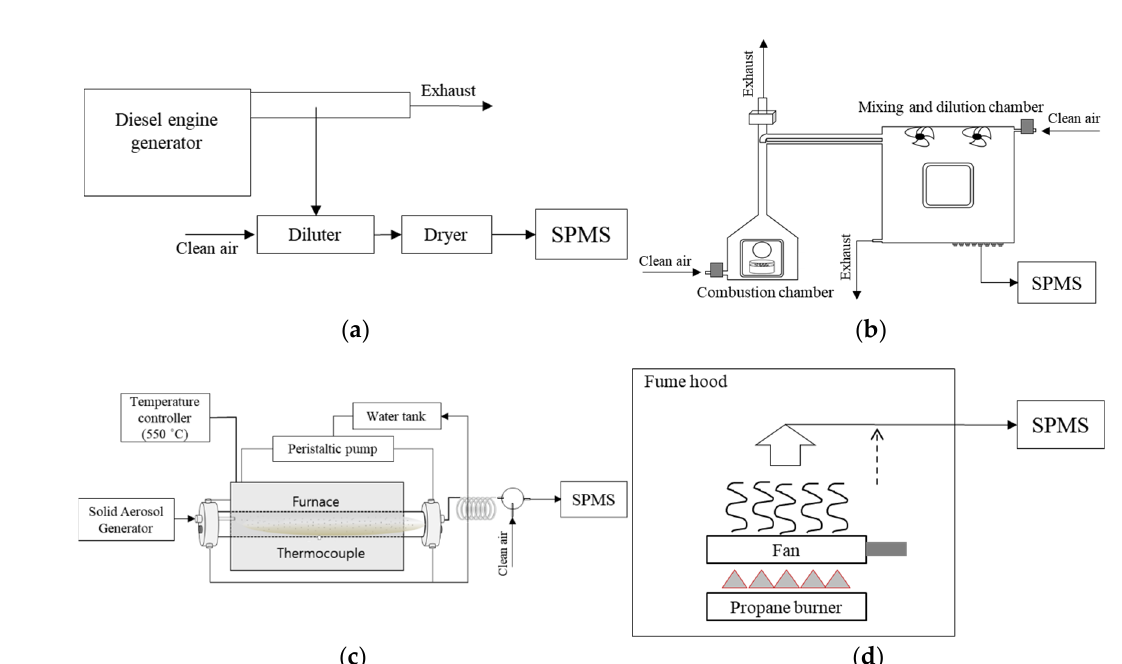
Figure 2. A schematic of various systems for generating combustion aerosols (( a ) diesel engine, ( b ) biomass burning, ( c ) coal burning, and ( d ) meat burning).